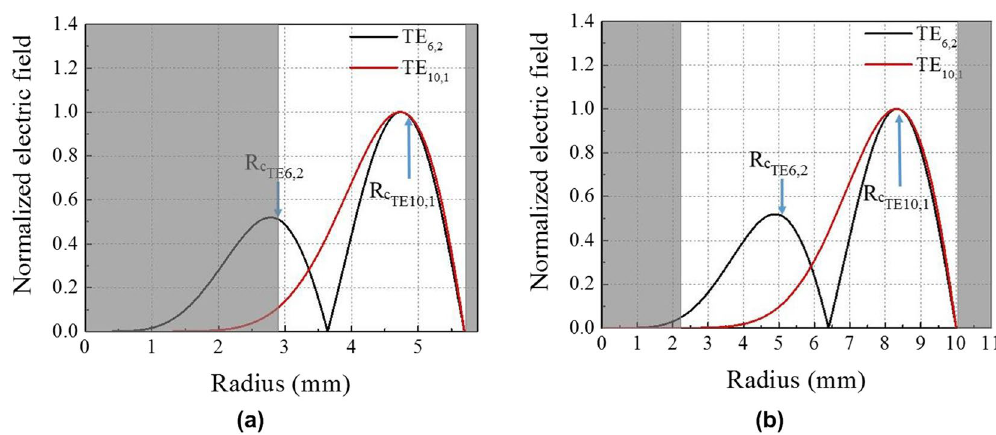
Figure 7. Calculated normalized electric field intensity versus the radius at ( a ) the center and ( b ) output end of the resonator. The shaded region indicates the metallic region comprising the cavity and inner